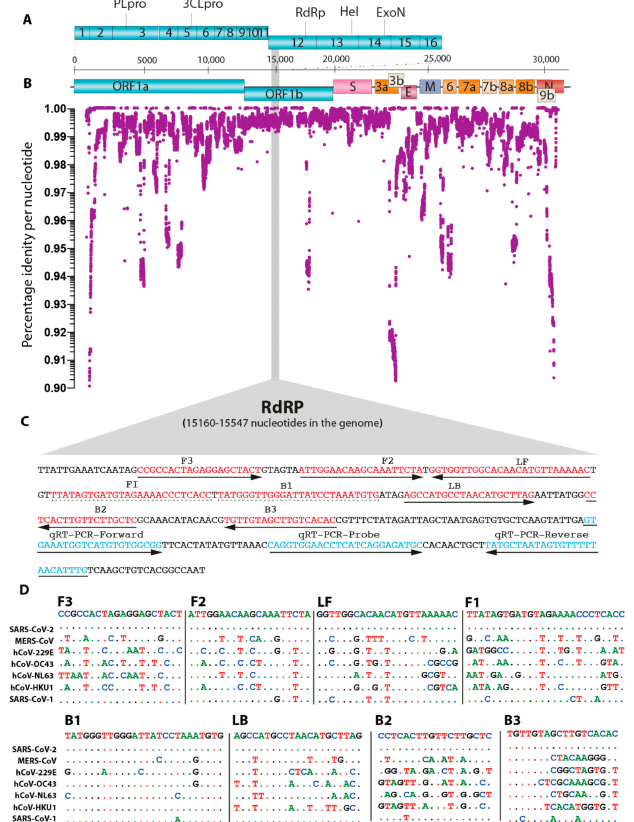
Figure 1. In silico analysis of SARS-CoV-2 and primers design. ( A ) Genome organization of SARS-CoV-2. Scale represents an approximate position of the genome, whereas ORF1a and b are expanded to show internal gene organization. ( B ) Level of gene identity across the genome of the SARS-CoV-2. Identity less than 90% is not shown. ( C ) Primers location in the RdRP gene of SARS-COV-2 is shown. Red coloured sequences represent LAMP primers whereas blue coloured sequences are primers and probes used in the qRT-PCR. ( D ) Comparative sequence identity using the primers against di ff erent human coronaviruses compared to the reference SARS-CoV-2 sequence; dots represent identical